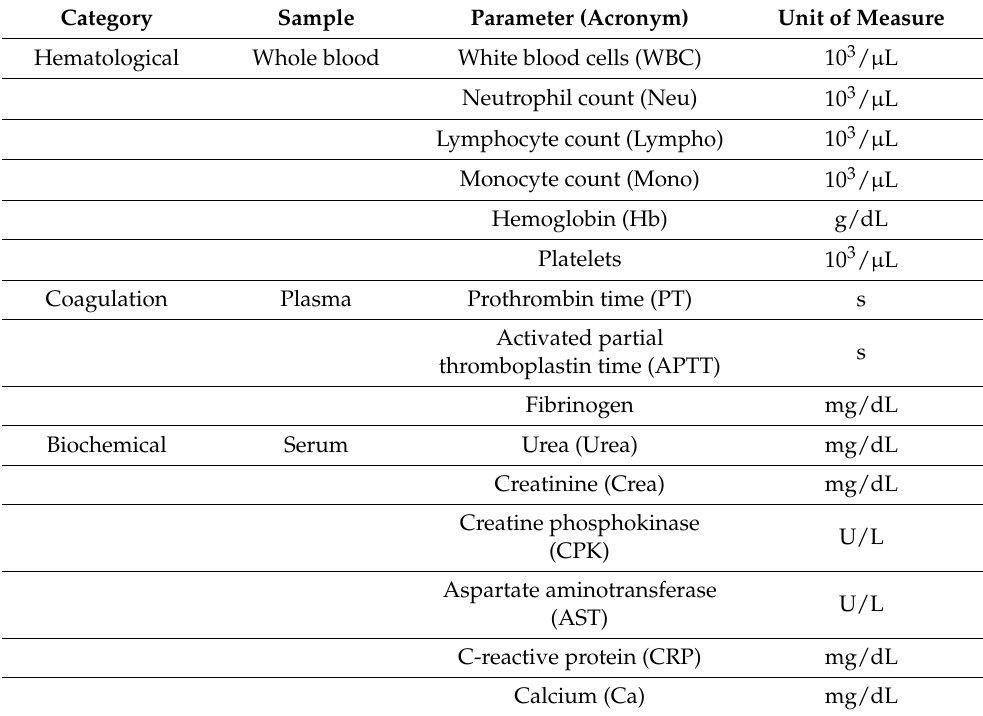
Table 1. List of the analyzed